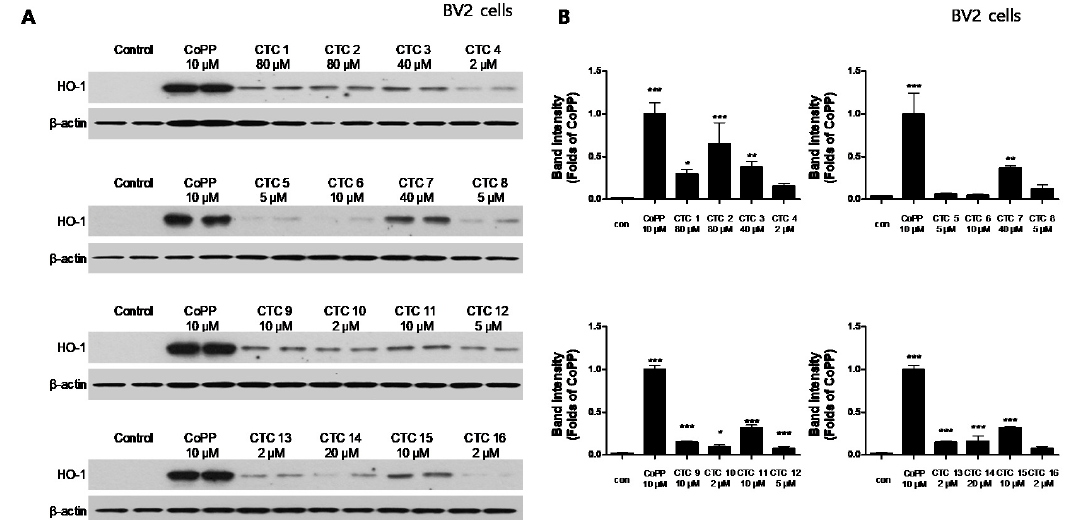
Figure 4. Effects of the sixteen C. tricuspidata compounds on the protein expression levels of HO-1 in BV2 cells. ( A ) Cells were incubated for 12 h with the indicated concentration of each compound and analyzed using western blotting. ( B ) Band intensities were normalized to β -actin. CoPP (10 μ M) was used as a positive control. Data are presented as the mean ± standard deviation of four independent experiments. * p < 0.05, ** p < 0.01, *** p < 0.001 when compared to the control group.